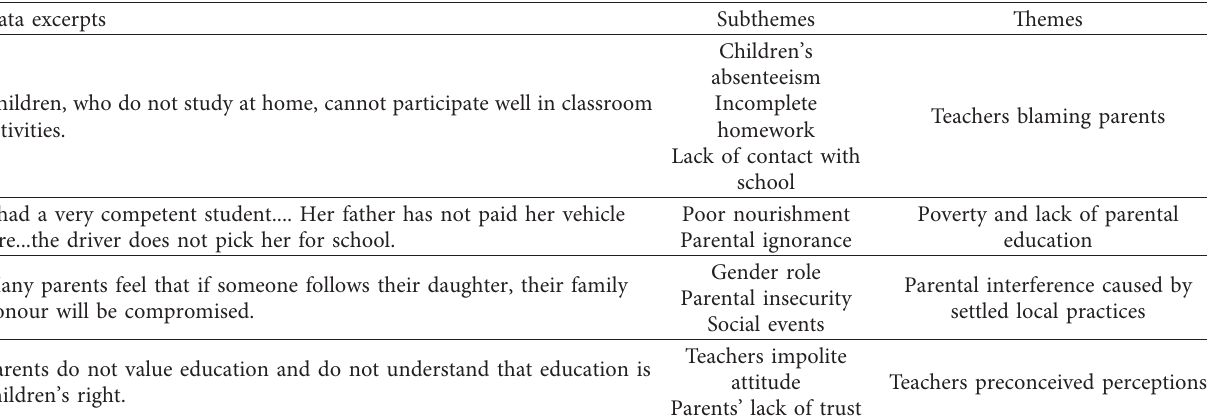
Table 1: Themes, subthemes, and excerpts from participant’s